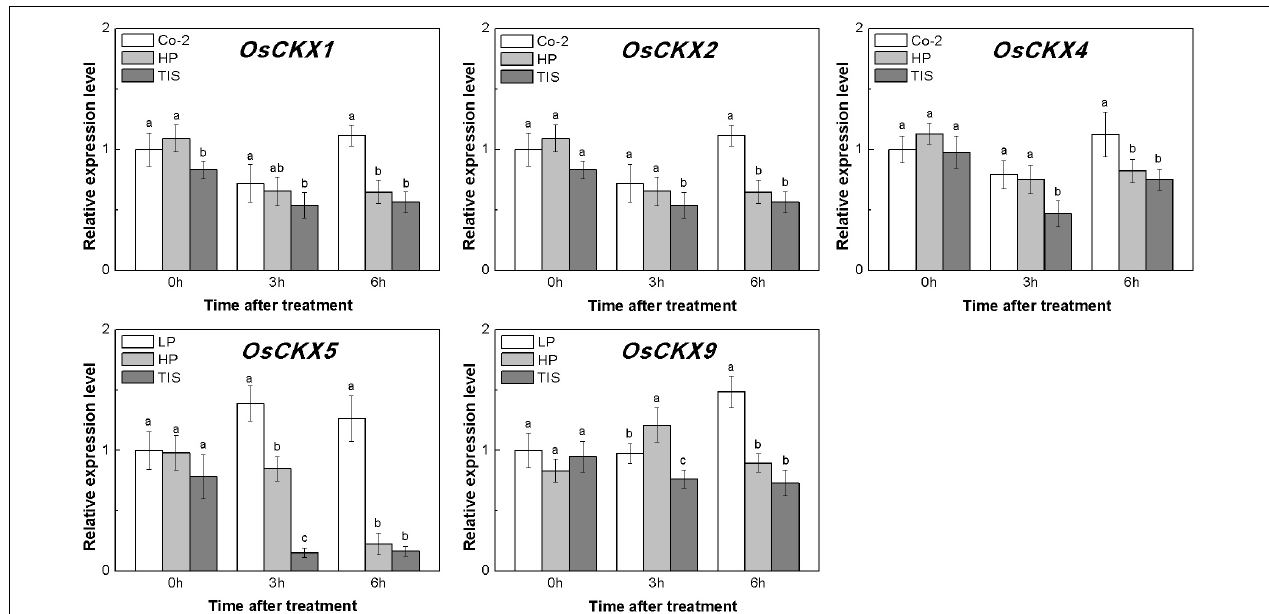
FIGURE 6 | Expression patterns of OsCKX1 , OsCKX2 , OsCKX4 , OsCKX5, and OsCKX9 CK degradation genes in rice tiller buds located at the fifth leaf axils expressed in response to the treatment. Co-2 contains 2 µ M P in a nutrient solution, HP contains 300 µ M P in a nutrient solution, and TIS contains 2 µ M P and 2 µ M TIS108 in a nutrient solution. Total RNA was isolated from less than 0.1 g of buds and nodes each time. β -Actin was used as a reference gene. The value obtained from the control treatment at 0 h after treatment was arbitrarily set at 1.0. Quantitative real-time PCR was performed in triplicate (three biological replicates), and mean values with SD are shown.